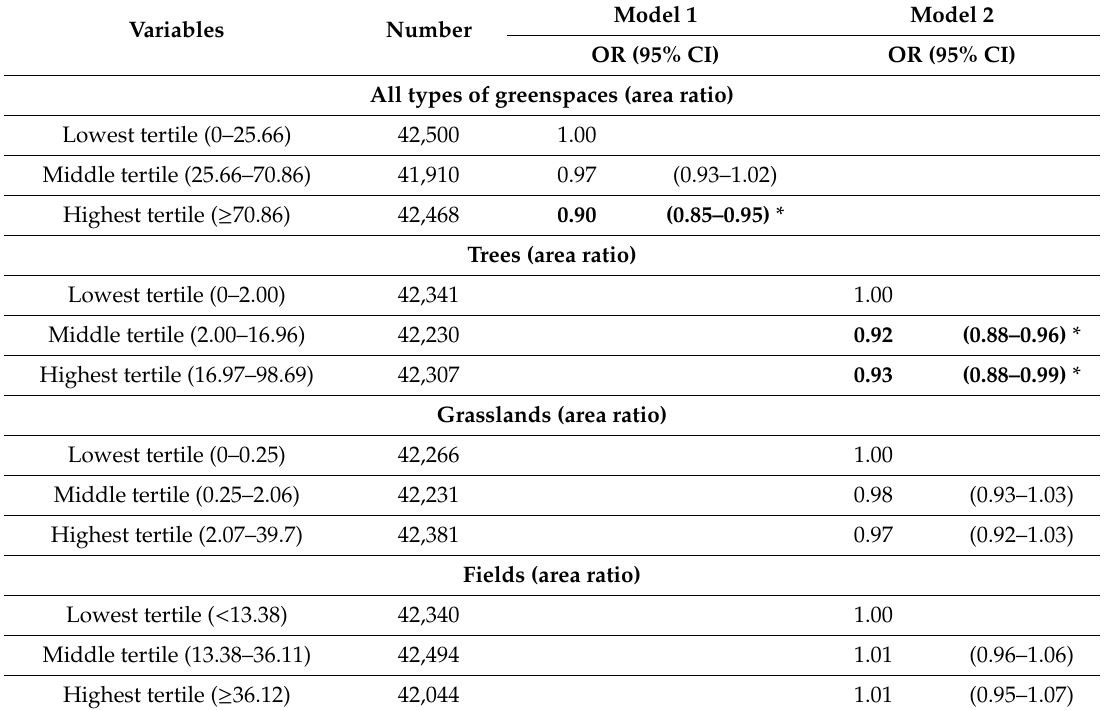
Table 3. Odds ratios (ORs) with 95% confidence intervals (95% CI) for the association of greenspace and depression among older Japanese adults ( n =